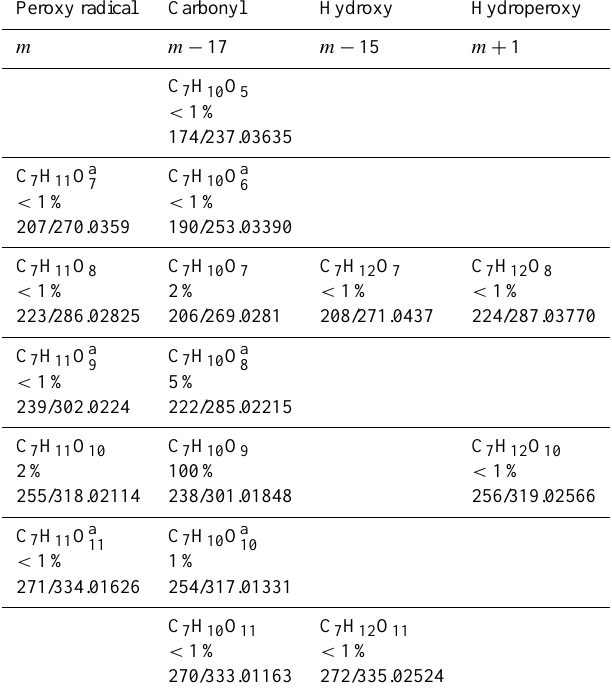
Table 10. HOM products observed during ozonolysis of 4-methyl- cyclohexene. The second header line shows at which molar masses the termination products are expected relative to the peroxy radi- cal with molar mass m (unit masses). Filled cells indicate that these compounds were detected with given elemental composition and relative intensity (second line in the same cell). Relative intensities were normalized to the largest HOM signal. The third line in the cell gives the molar mass [Da] in unit mass resolution and the pre- cise m/z [Th] at which the molecule was detected as cluster with 15 NO − . 3